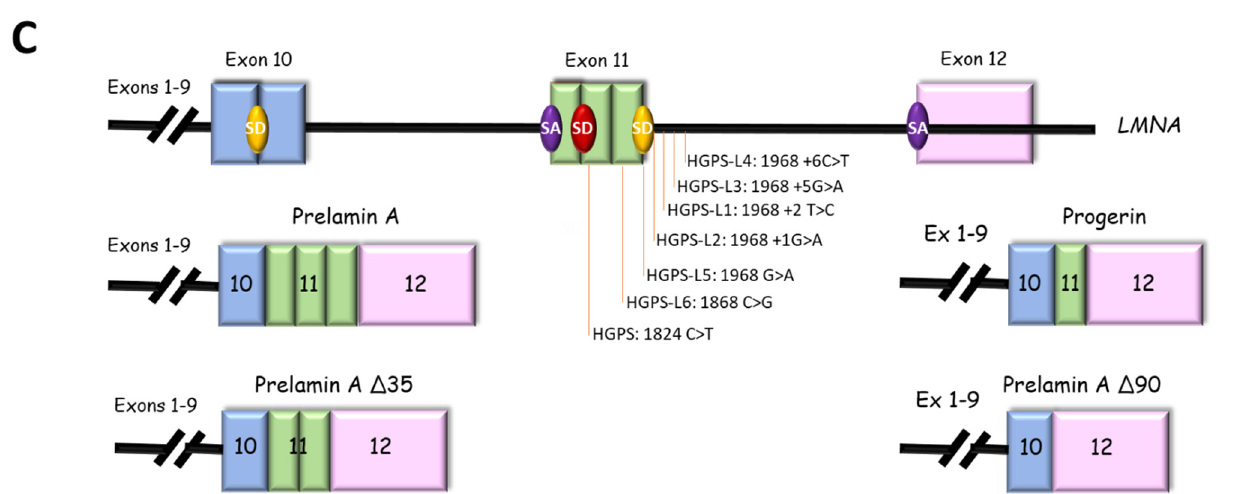
Figure 1. Clinical and molecular description of cell lines. ( A ) Pictures and electropherograms of patient HGPS-L4 at age 6 years showing progeroid features, including sparse hair and eyebrows, small chin, a thin nose, prominent nipples, dyspigmentation with hyper/hypo-pigmented areas, and sclerodermatous changes on her chest. The heterozygous c.1968+6C>T LMNA mutation was confirmed by Sanger sequencing. ( B ) Characterization of LMNA and FACE1 (ZMPSTE24) gene mutations in HGPS-like and MAD-B patients eliciting aberrant prelamin A splicing or wild-type prelamin A accumulation. Variable disease severities compared to classical HGPS are indicated with “+”: more, “ − “: less, or “=”: equal severity. The ratios of aberrant prelamin A to lamin A isoforms are shown, issued from Western blot data, except for prelamin A, against which no antibodies are available, and so were determined based on the transcript levels. ( C ) Locations of LMNA mutations and schematic representation of the aberrant prelamin A isoforms. SD: splice donor site, SA: splice acceptor